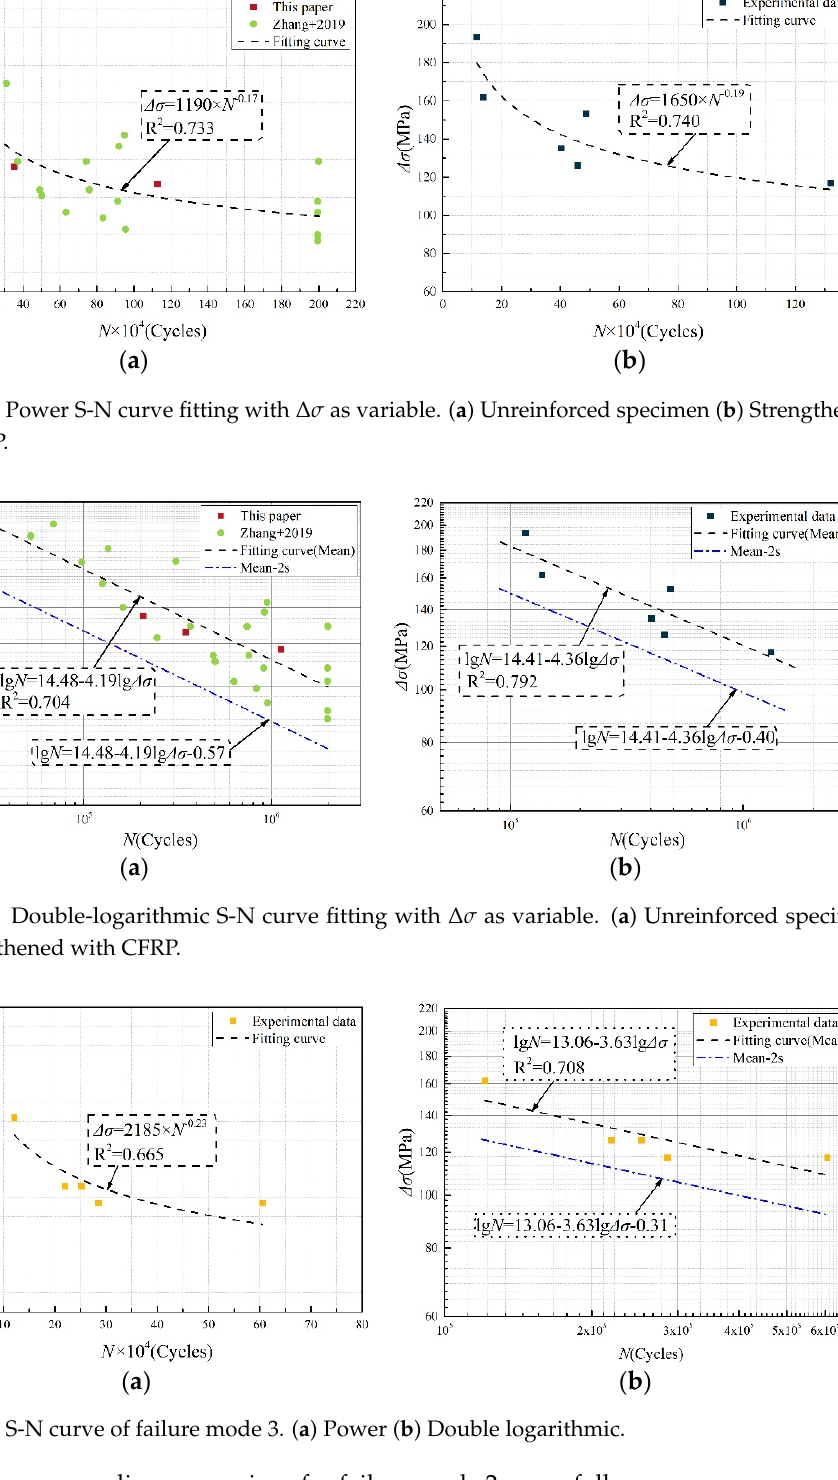
Figure 16. S-N curve of failure mode 3. ( a ) Power ( b ) Double logarithmic.